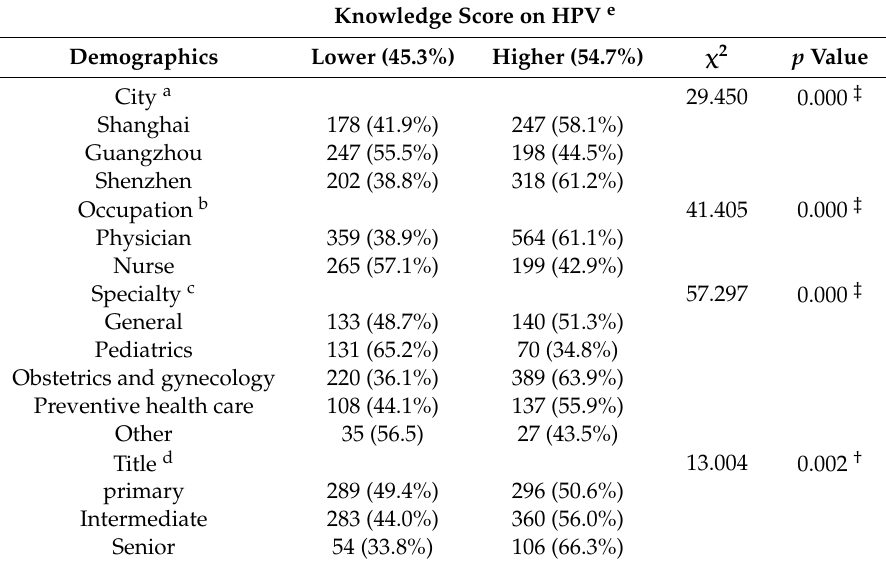
Table 2. Distribution of respondents between “lower” and “higher” groups based on their HPV knowledge scores.